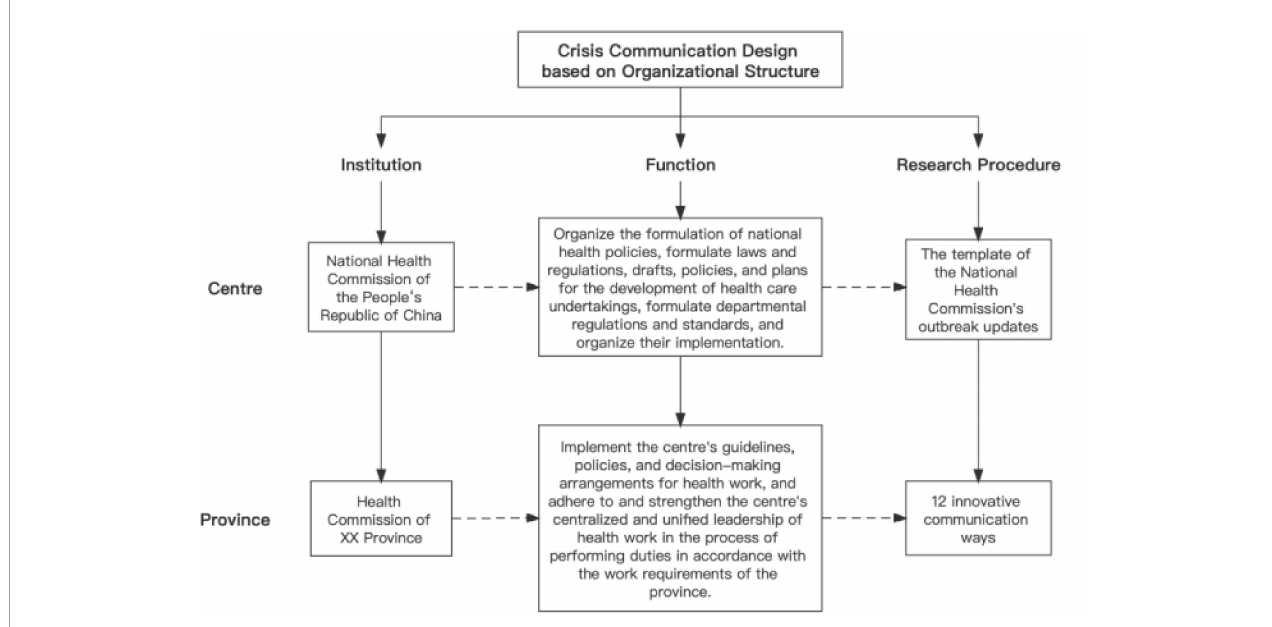
FIGURE1 China’s central–provincial relations in crisis